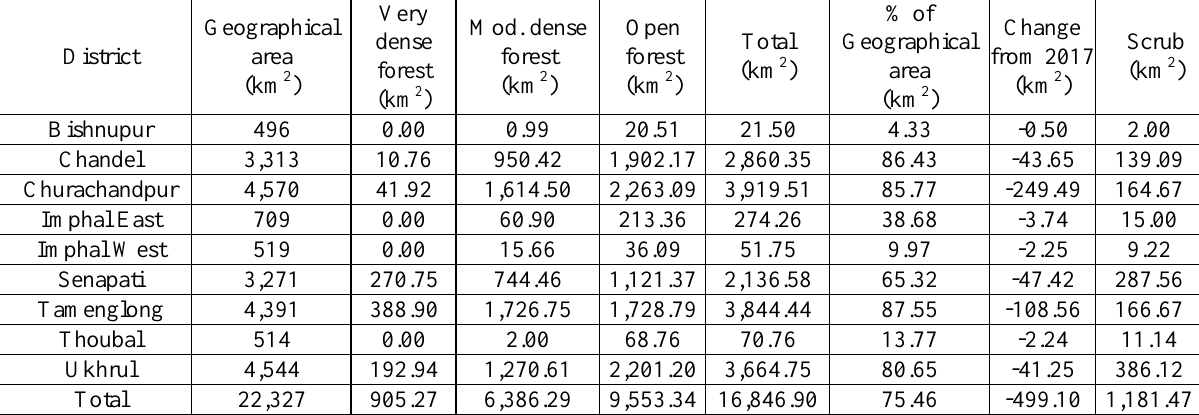
Table 2. District-wise forest cover (2019) assessment